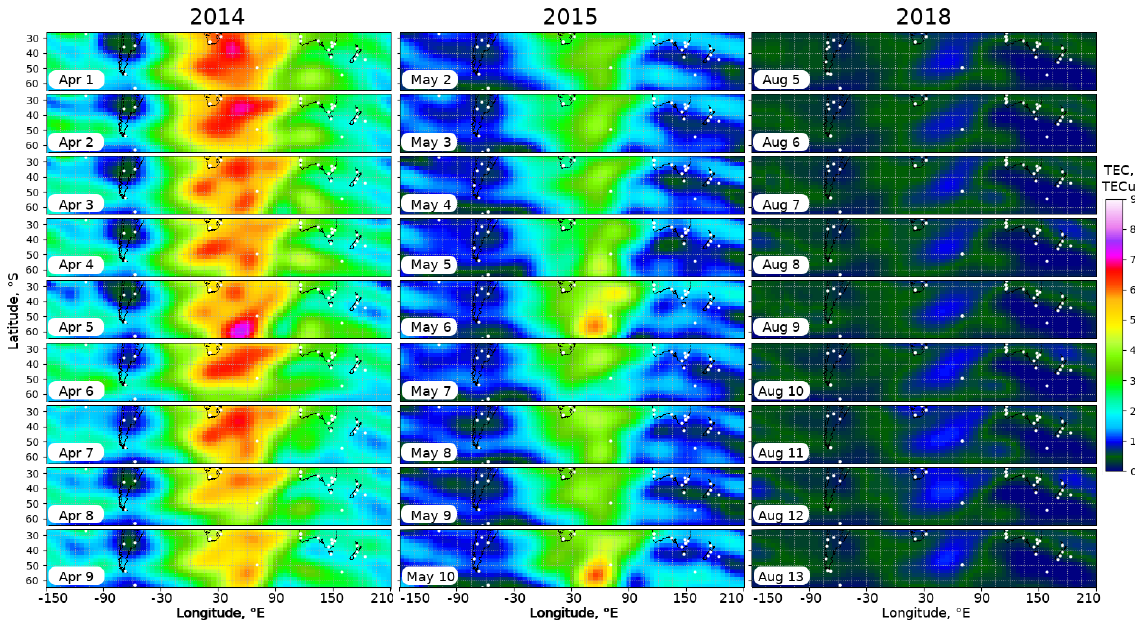
Figure 3. Series of LTEs observed in the SH at 10:00UT during years with solar activity.